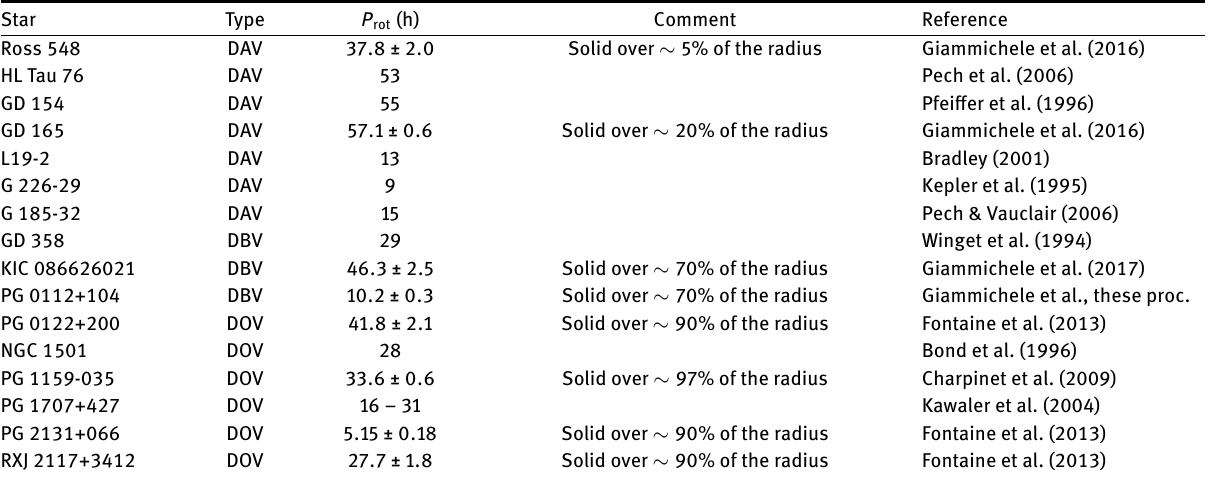
Table 3. List of isolated pulsating white dwarfs with a rotation period derived from